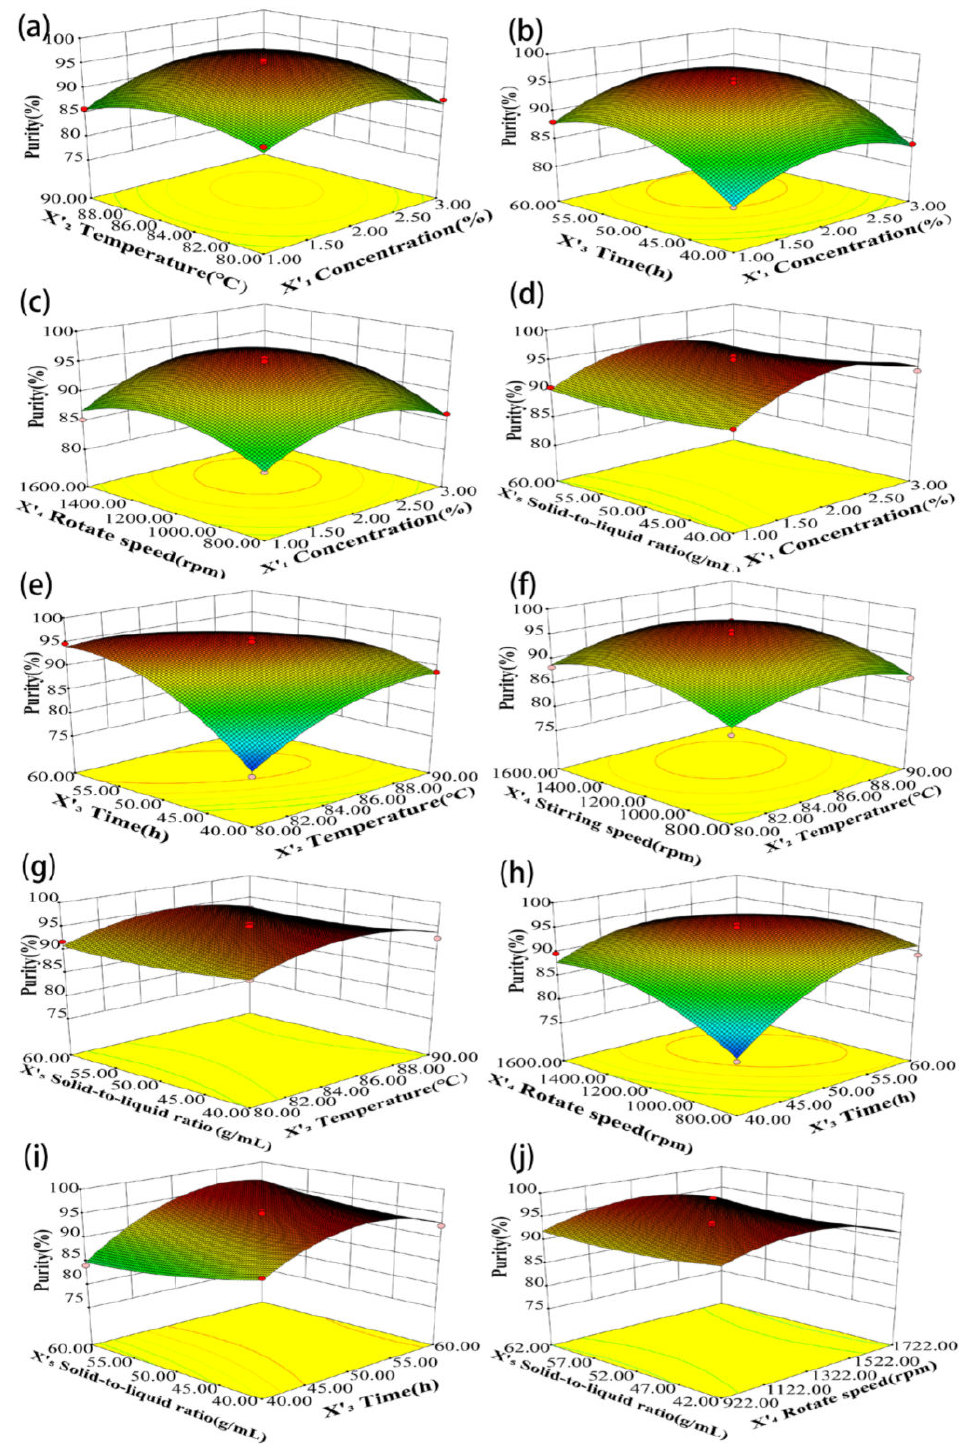
Figure 7. 3D response surface curves of interactive effects between different aqueous phase dispersion factors. ( a ) X (cid:48) 1 X (cid:48) 2 , ( b ) X (cid:48) 1 X (cid:48) 3 , ( c ) X (cid:48) 1 X (cid:48) 4 , ( d ) X (cid:48) 1 X (cid:48) 5 , ( e ) X (cid:48) 2 X (cid:48) 3 , ( f ) X (cid:48) 2 X (cid:48) 4 , ( g ) X (cid:48) 2 X (cid:48) 5 , ( h ) X (cid:48) 3 X (cid:48) 4, ( i ) X (cid:48) 3 X (cid:48) 5 , ( j ) X (cid:48) 4 X (cid:48) 5 . ( X (cid:48) 1 , concentration; X (cid:48) 2 , temperature; X (cid:48) 3 , time; X (cid:48) 4 , stirring speed; X (cid:48) 5 , material-to-liquid ratio) The optimal aqueous phase dispersion conditions predicted by BBD were concentra- tion 1.69%, temperature 80.40 ◦ C, time 59.94 h, stirring speed 1120.94 rpm, and material- to-liquid ratio 1:58.96 g/mL, under which the predicted purity of gutta-percha was